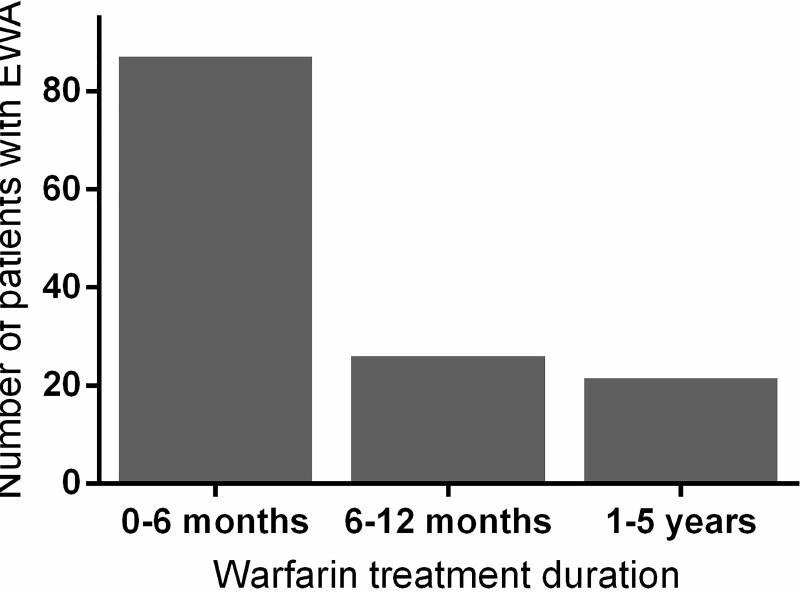
Fig 2. Number of patient with EWA per 6-month episodes from the initiation of warfarin. Data on patients with warfarin treatment durationof more than 5 years are not shown. https://doi.org/10.1371/journal.pone.0175975.g002 PLOS ONE | https://doi.org/10.1371/journal.pone.0175975 April 20,